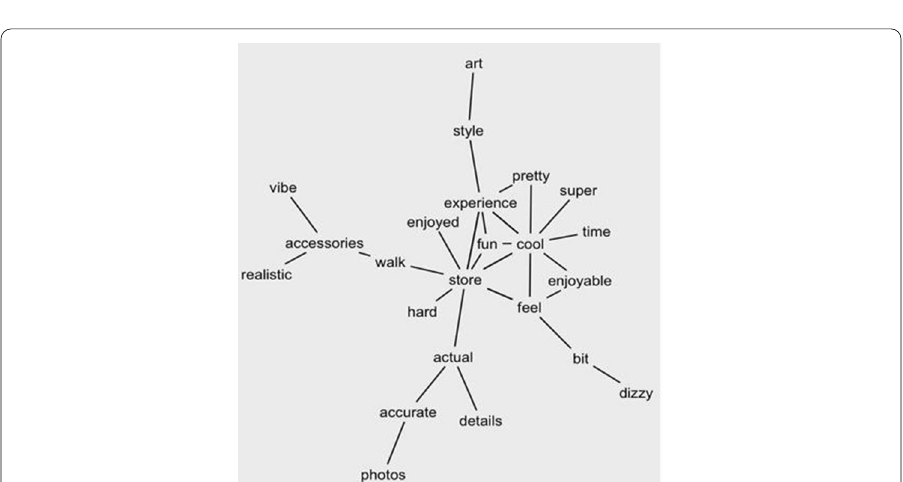
Fig. 3 Semantic network analysis result using R: The relationship of two words reported commonly